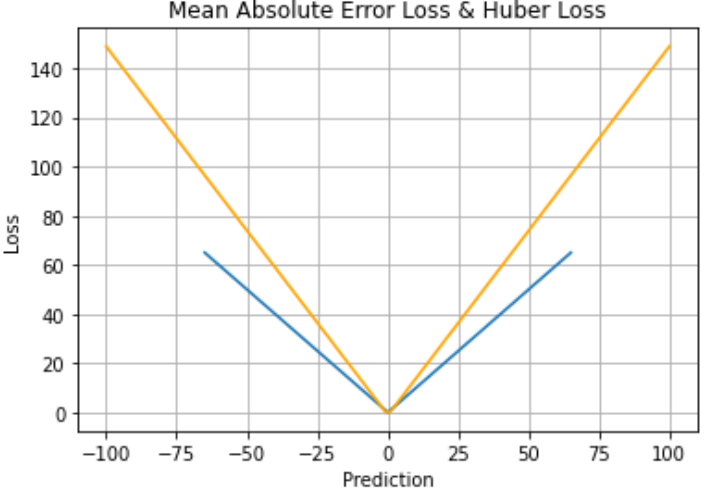
Figure 7. Mean Square Error Loss & Huber loss.